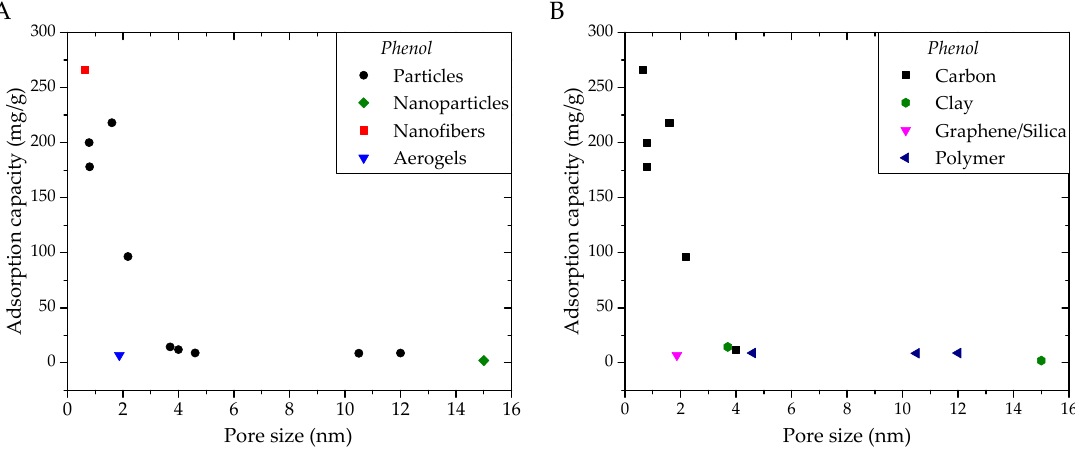
Figure 6. Phenol adsorption capacity related to the pore size of different adsorbent structures ( A ) and compositions ( B ).